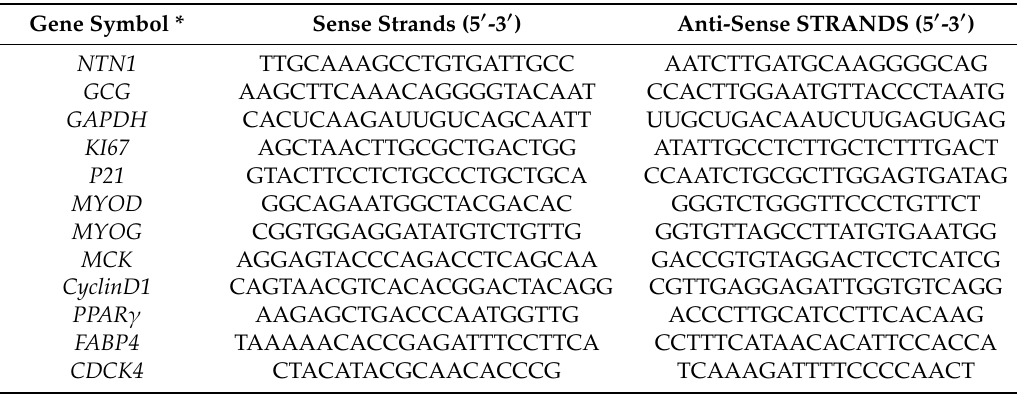
Table 1. Primer sequences for